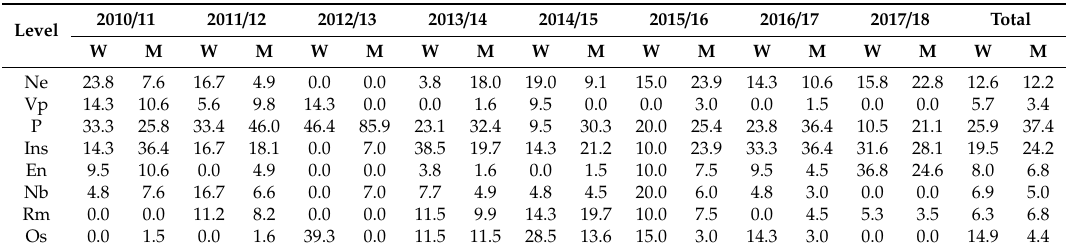
Table 5. Level of achievement of handstand according to academic years, temporary totality and gender.